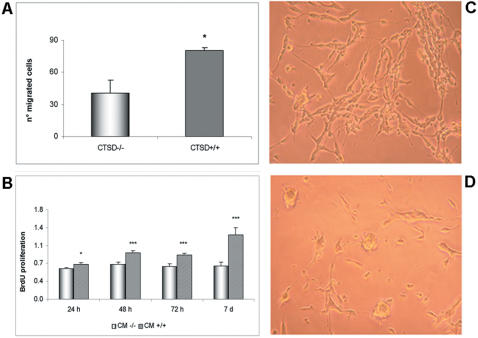
Stromal cathepsin D expression promotes PNEC cell migration and proliferation.(A) Quantification of PNEC cell migration in 3D matrigel co-culture with cathepsin D-deficient (CTSD−/−) or wild-type (CTSD+/+) fibroblasts after 30h of co-culture; (B) PNEC cell proliferation and (C, D) elongation are increased in the presence of conditioned medium (CM) derived from CTSD+/+ fibroblasts (C), compared to CM derived from CTSD−/− fibroblasts (D).Experiments were performed three times, each time in quintuplicate.Representative results are shown.*p<0.05, ***p<0.001, Student t test.